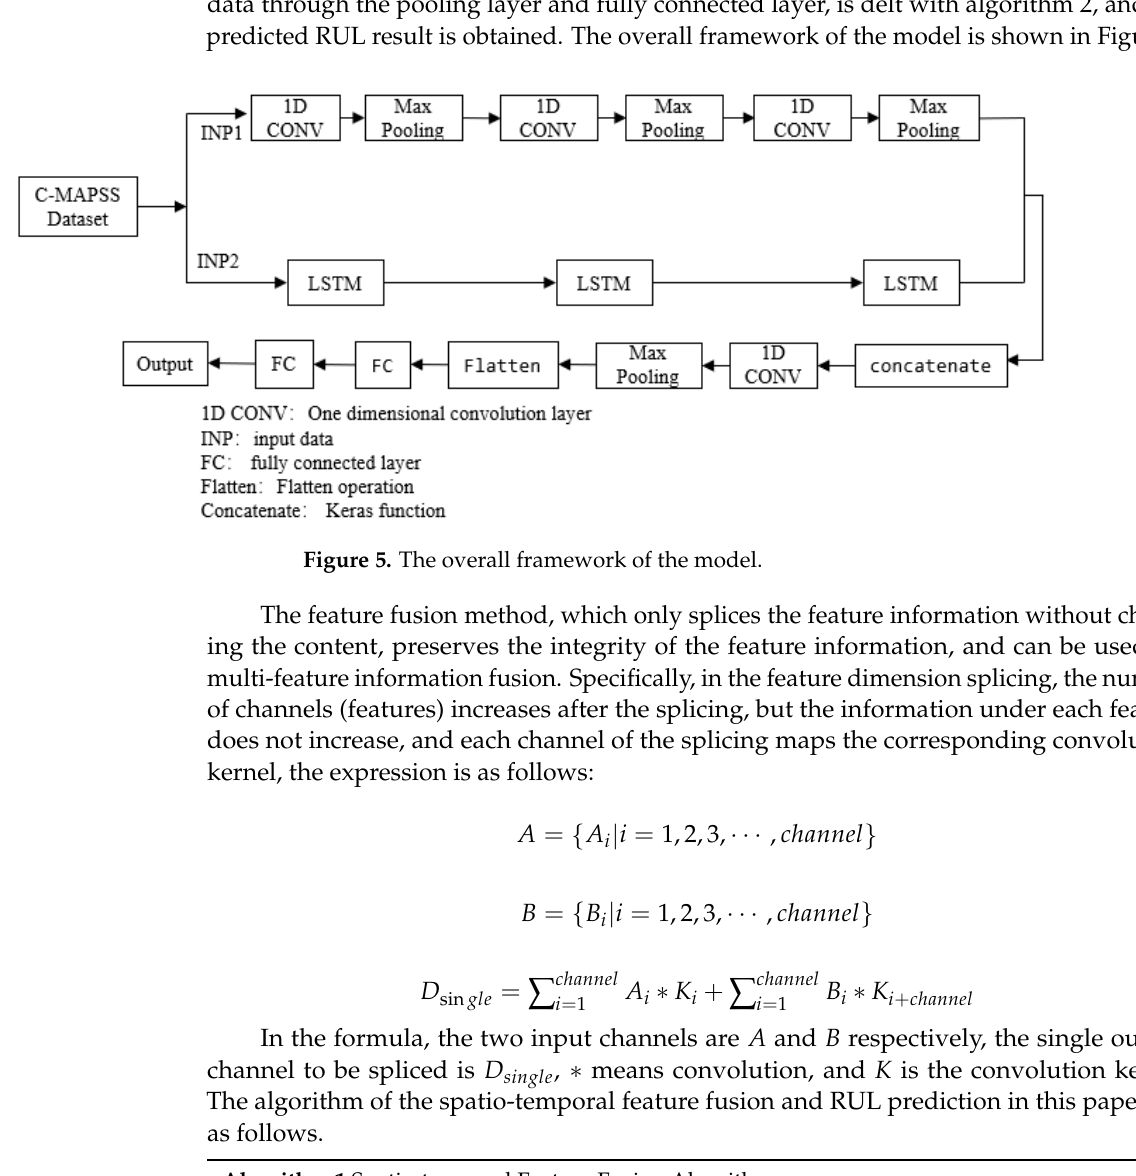
Algorithm 1 Spatio-temporal Feature Fusion